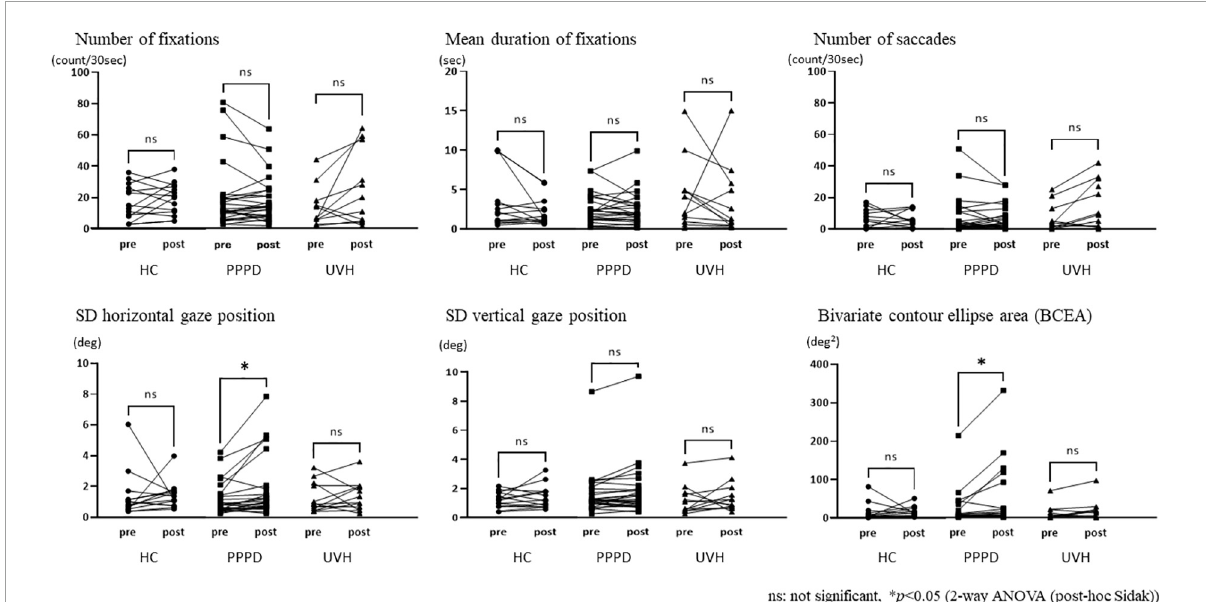
FIGURE3 Comparisons of the parameters of gaze stability between pre- and post-stimuli states among the three groups. The standard deviation (SD) horizontal gaze position and bivariate contour ellipse area were significantly greater post-stimulus than pre-stimulus (SD horizontal gaze position; p = 0.050, r = 0.32) (bivariate contour ellipse area; p = 0.014, r = 0.38) in the persistent postural-perceptual dizziness group.